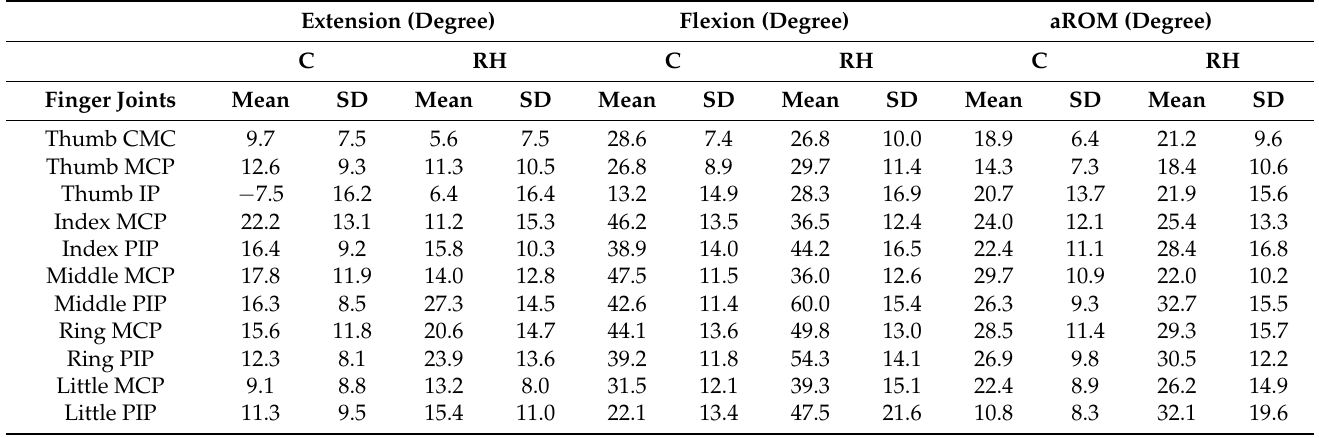
Table 4. Range of motion (ROM) during the sixteen activities (control and right hemiparesis). Extension (Degree)